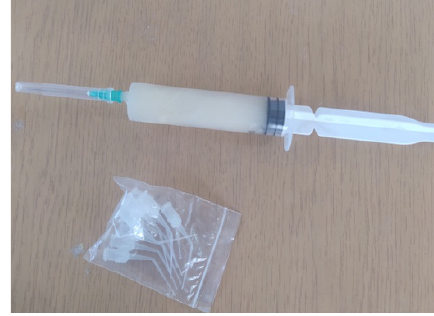
Figure 2. Hydrogel syringe with special heads